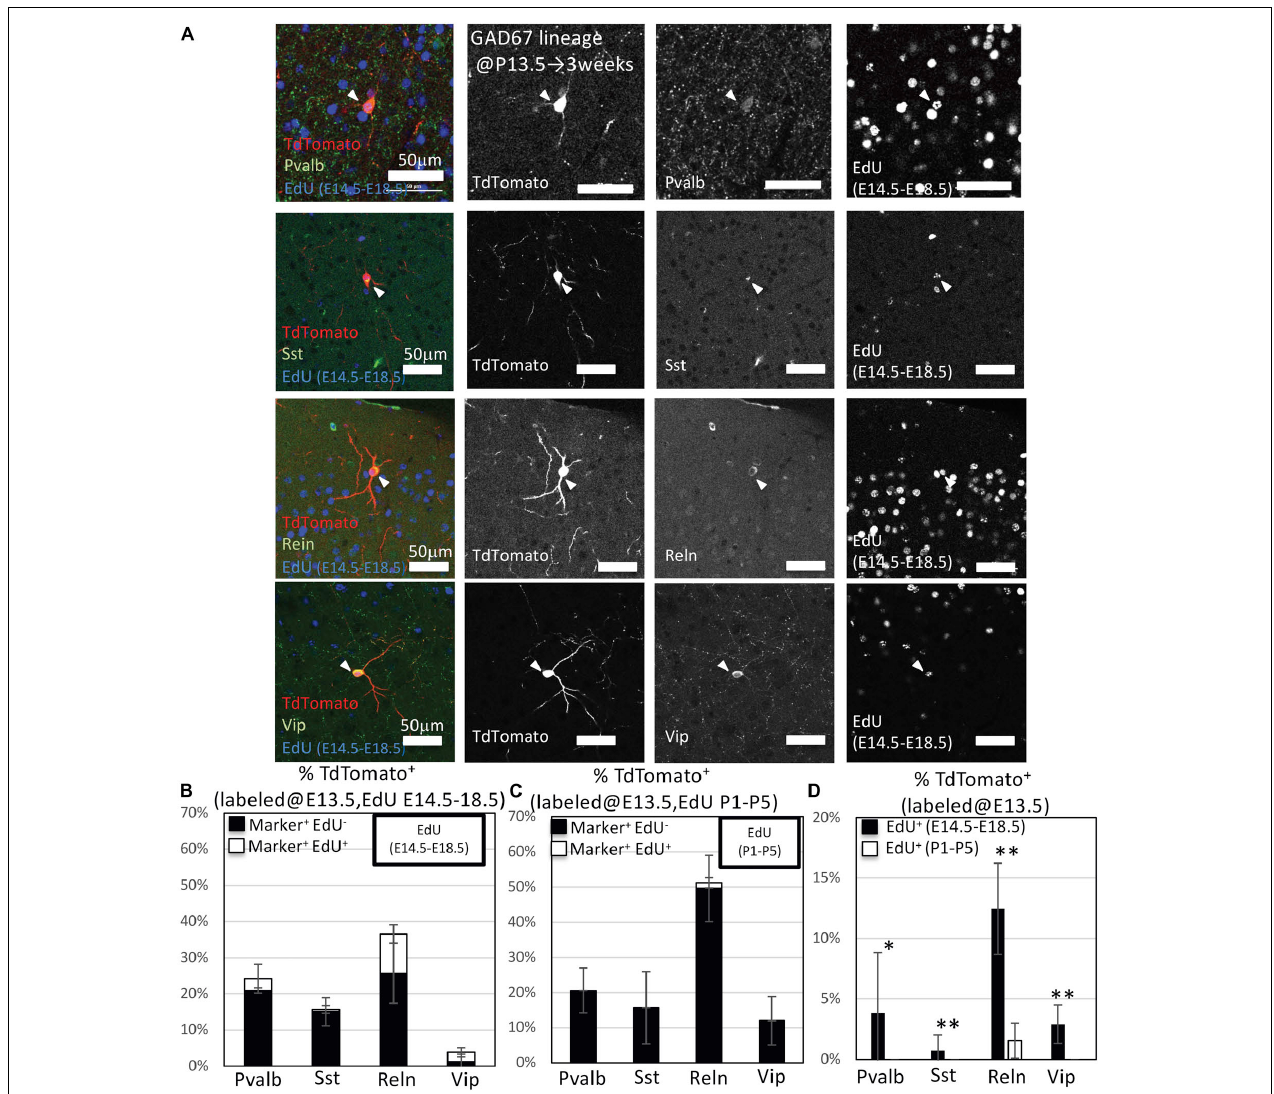
FIGURE 6 | Immunohistochemistry analysis of GAD67-lineage cells labeled at E13.5. (A) Triple-fluorescence immunohistochemistry of GAD67-lineage cells (red; labeled at E13.5) for EdU (green; labeled E14.5–E18.5) and GABAergic (Pvalb, Sst, Reln, and Vip) neuron markers (green) from GAD67-CrePR;Ai9 mice at 3 weeks of age. White arrowheads indicate the triple-positive cells. Pvalb, parvalbumin; Sst, somatostatin; Reln, reelin; Vip, vasoactive intestinal peptide. (B) Percentage of TdTomato + cells labeled with EdU (E14–E18), and/or GABAergic (Pvalb, Sst, Reln, and Vip) neuron subtype markers. Black bars indicate the percentages of TdTomato + and GABAergic neuron subtype marker double-positive cells. White bars indicate the percentages of TdTomato + GABAergic neuron subtype marker and EdU + triple-positive cells. (C) Percentage of TdTomato + cells labeled with EdU (P1–P5) and/or GABAergic (Pvalb, Sst, Reln, and Vip) neuron subtype markers. Black bars indicate the percentages of TdTomato + and GABAergic neuron subtype marker double-positive cells. White bar indicates the percentage of TdTomato + GABAergic neuron subtype marker and EdU + triple-positive cells. (D) Percentages of TdTomato + EdU + GABAergic neuron subtype marker + GAD67-lineage cells labeled at E13.5 and EdU injected from E14.5 to E18.5 or P1 to P5. ∗ P < 0.05; ∗∗ P <